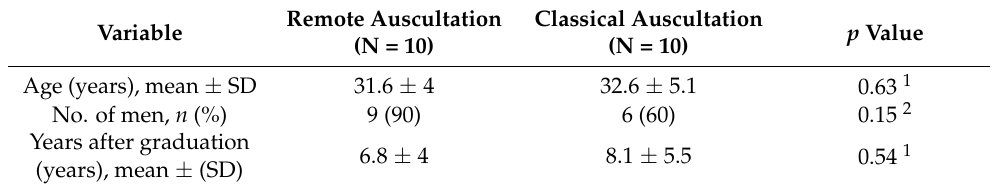
Figure 4. Flowchart of participants in the study. Table 1. Baseline characteristics of participants in the classical and remote auscultation groups.